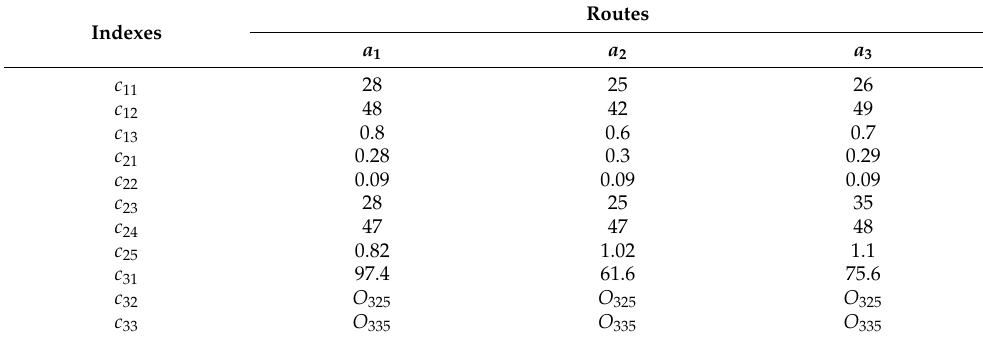
Table 2. Environment data of